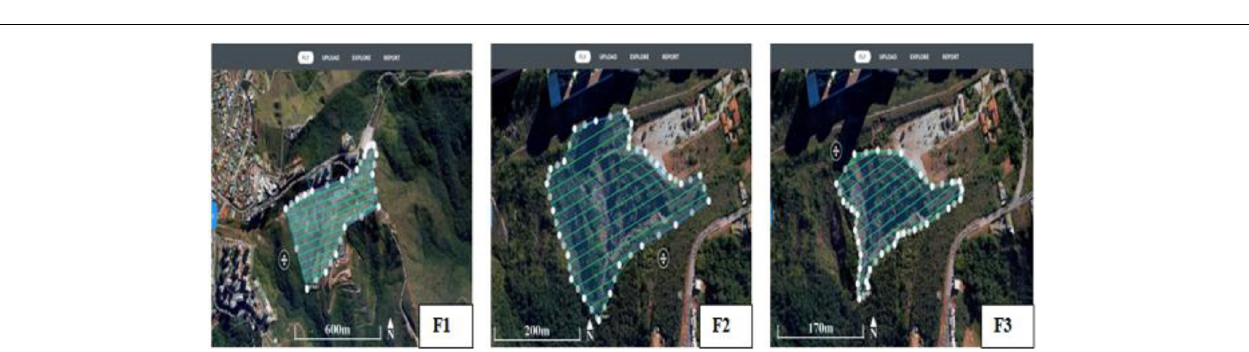
FIGURE 2 | Study area with the location of the gullies in the “Estrangulado” stream sub-basin, Nova Lima-MG, Brazil. Source: Vieira and Almeida, 2018.